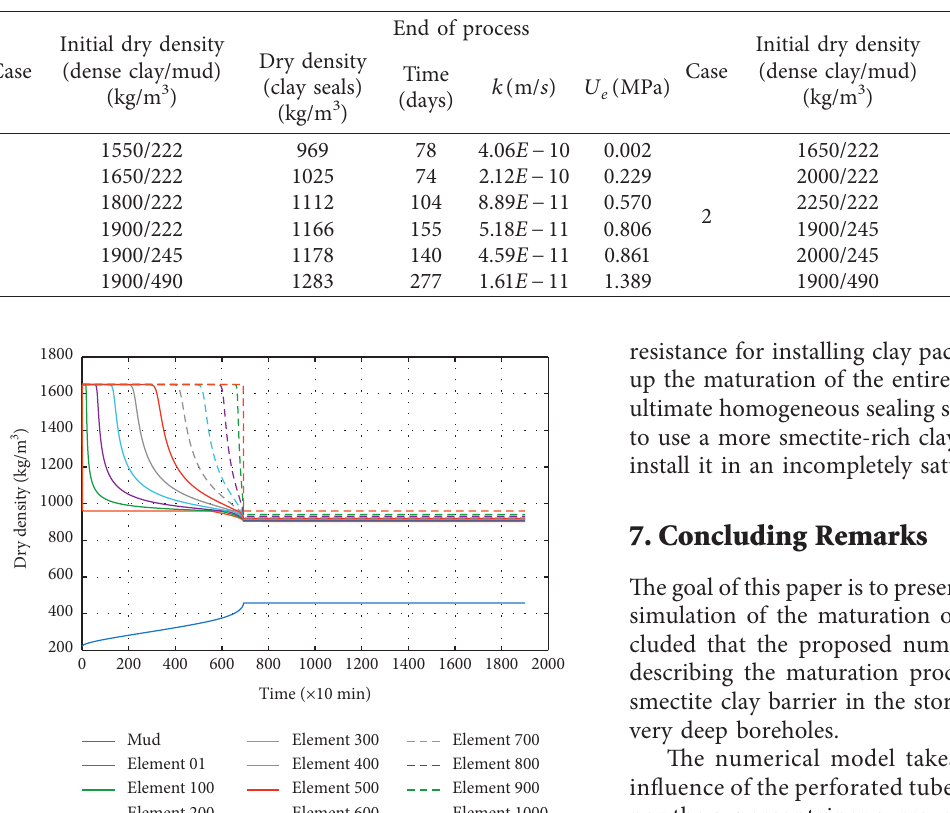
Figure 10: Maturation of clay seals in real Case 2. Plotting with mud and every 100th element.